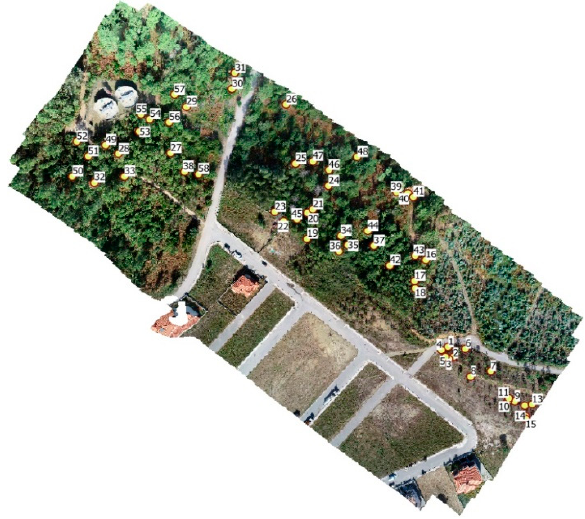
Figure 3. Training points (trees) identified in one site near Sertã.